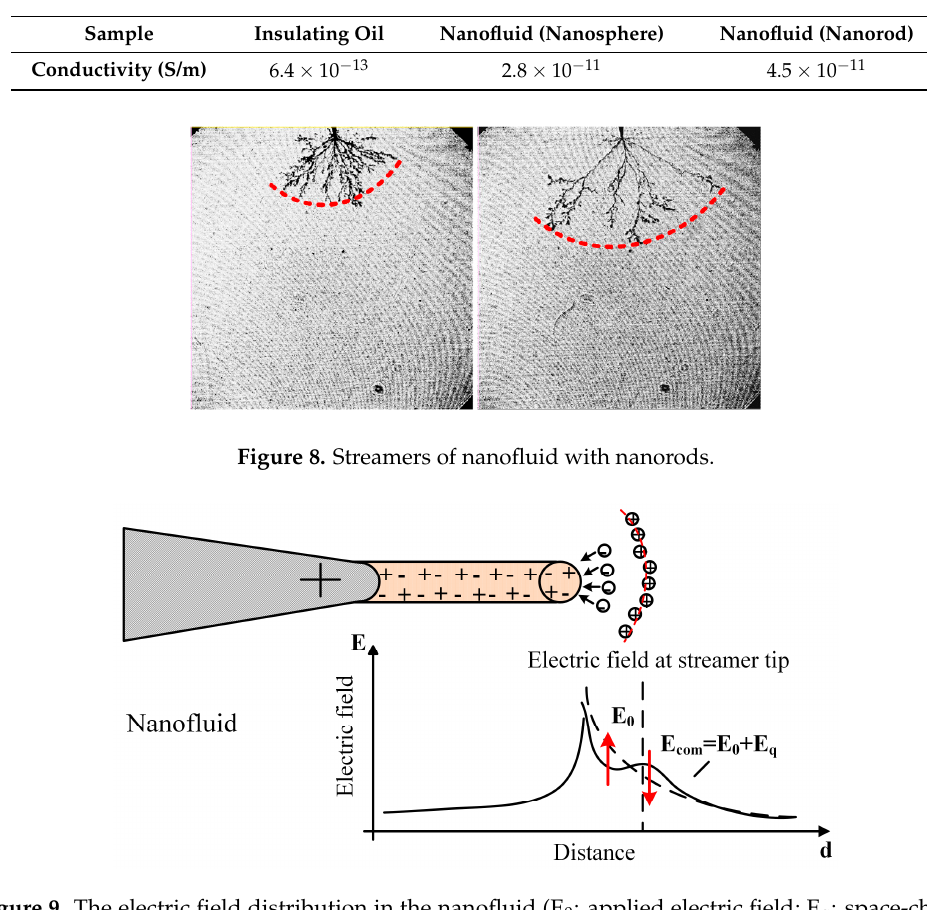
Figure 9. The electric field distribution in the nanofluid (E 0 : applied electric field; E q : space-charge electric field).